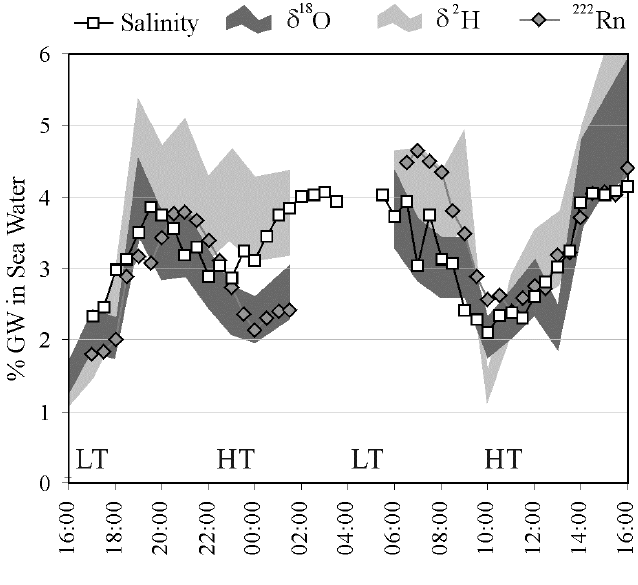
Figure 10. Percentage of groundwater in the water in the submarine cave at